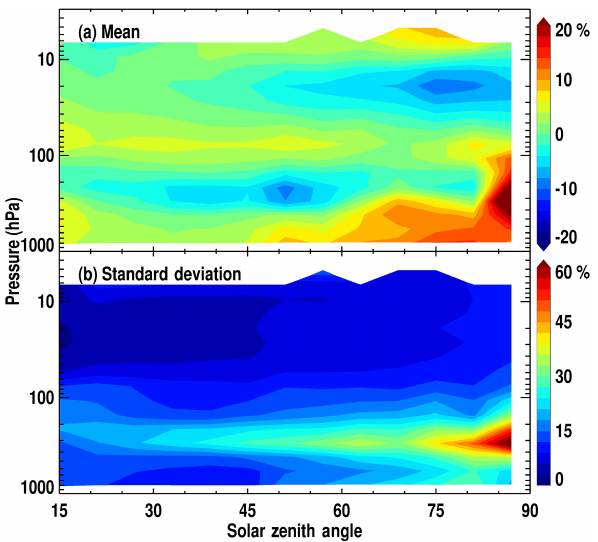
Figure 5. Mean relative biases in ozone (a) and standard devi- ations (b) of the differences between OMI and ozonesonde con- volved with OMI AKs as a function of solar zenith angle using all OMI–ozonesonde coincidences during 2004–2014.